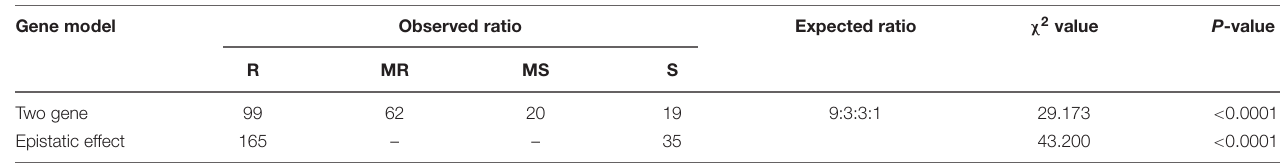
TABLE 3 | Chi-square test for independent gene model (9:3:3:1) and epistatic effect (15:1) for blast resistance in BC 2 F 2 population inoculated with pathotype P7.2 of Magnaporthe oryzae.